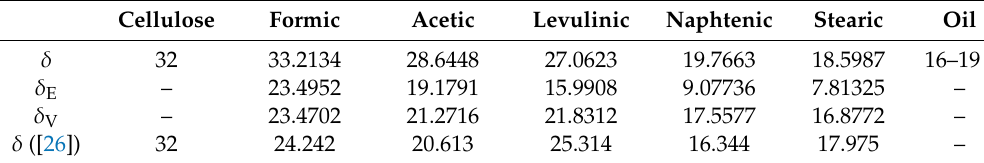
Table 6. The solubility parameters of the acids ((J · cm − 3 ) 0.5